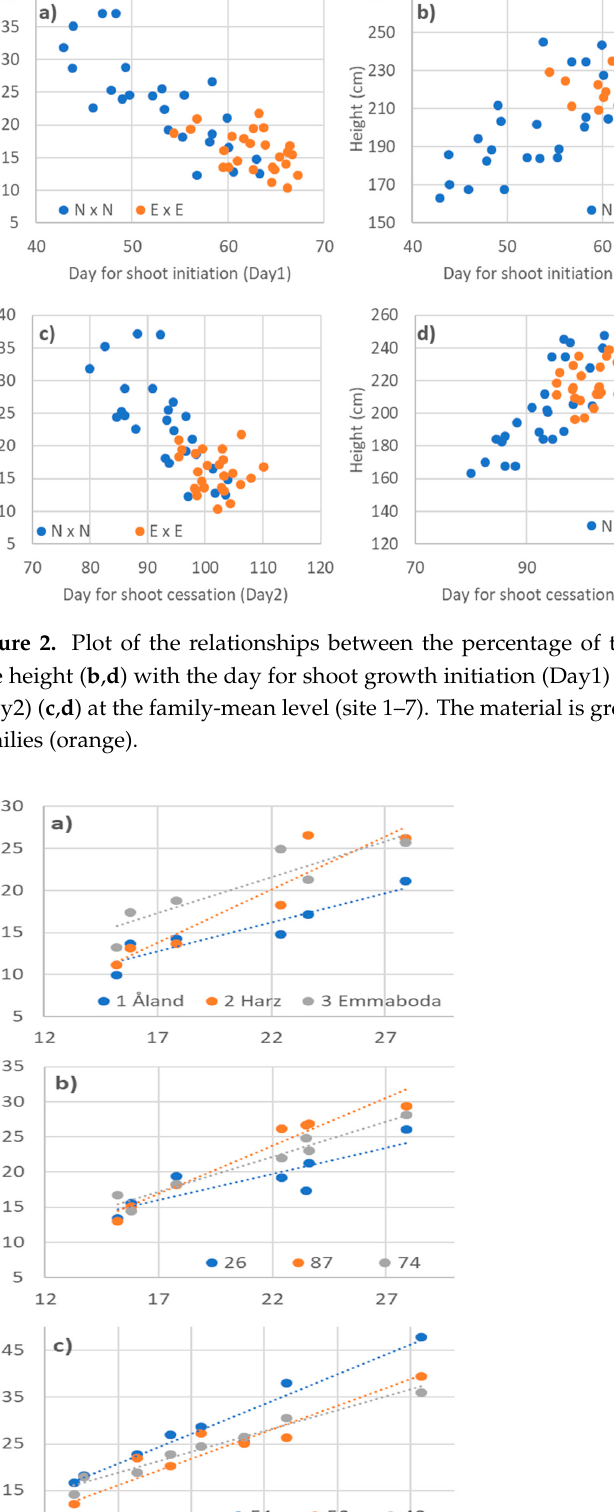
Table 5. Estimates of regression coefficients for annual height increment of 100 full-sib families planted at seven sites (sites 1–7). The regression coefficients of the N × N and E × E families are shaded.